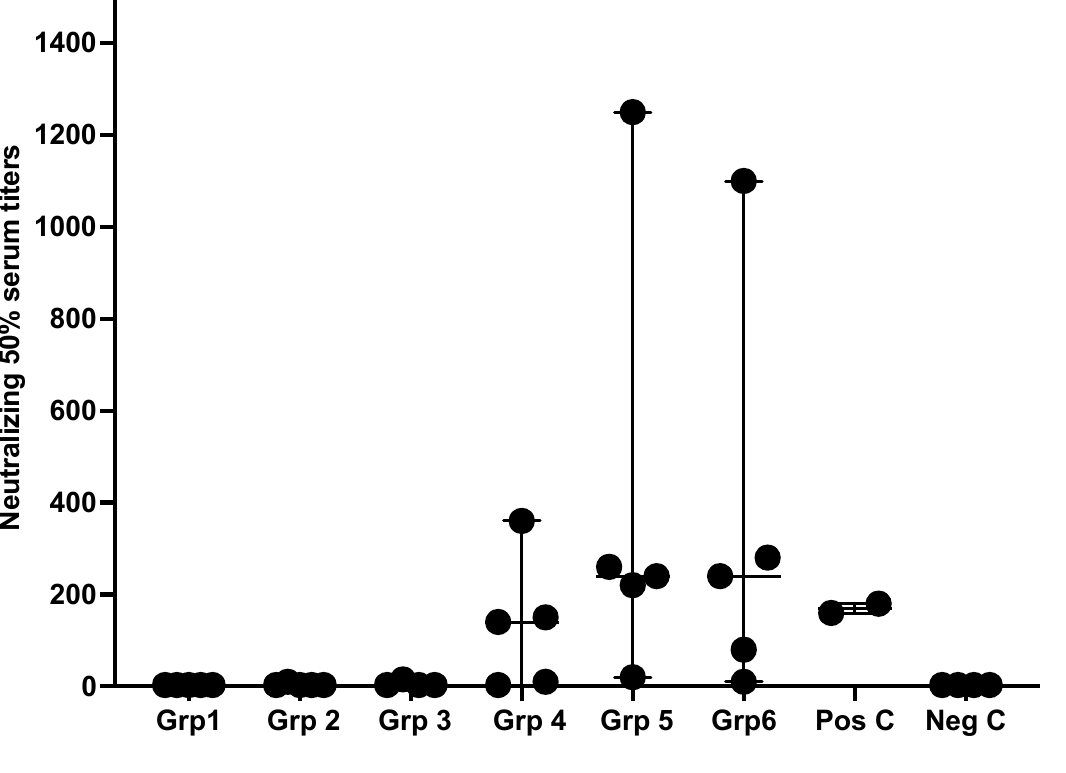
Figure 2. Microneutralizing serum antibodies titers. Serum antibody titers (NT) were obtained from mouse groups after three weeks of receiving the second immunizing dose of formulated vaccines. Serum antibodies levels were determined by endpoint neutralization of a 50% cell culture infectious and after 96 h of culture periods. Pos C is positive control while Neg C is the negative control group. Data are driven from 5 individuals per group, p value < 0.05.